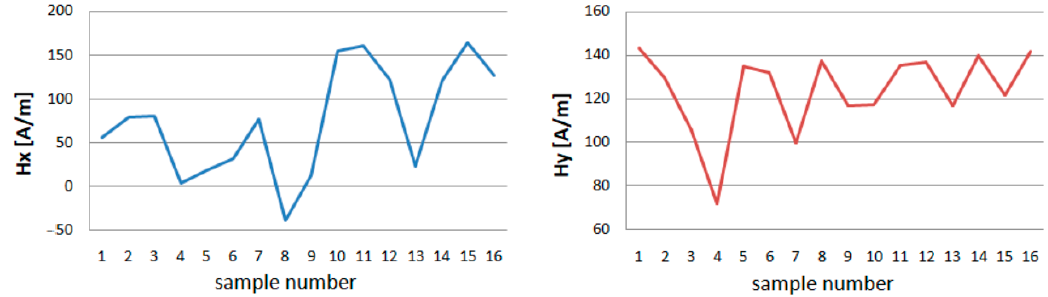
Figure 6. Minimum of tangential Hx and normal component Hy after repeatedly applying variants A, B, C, D, for 4 days long.